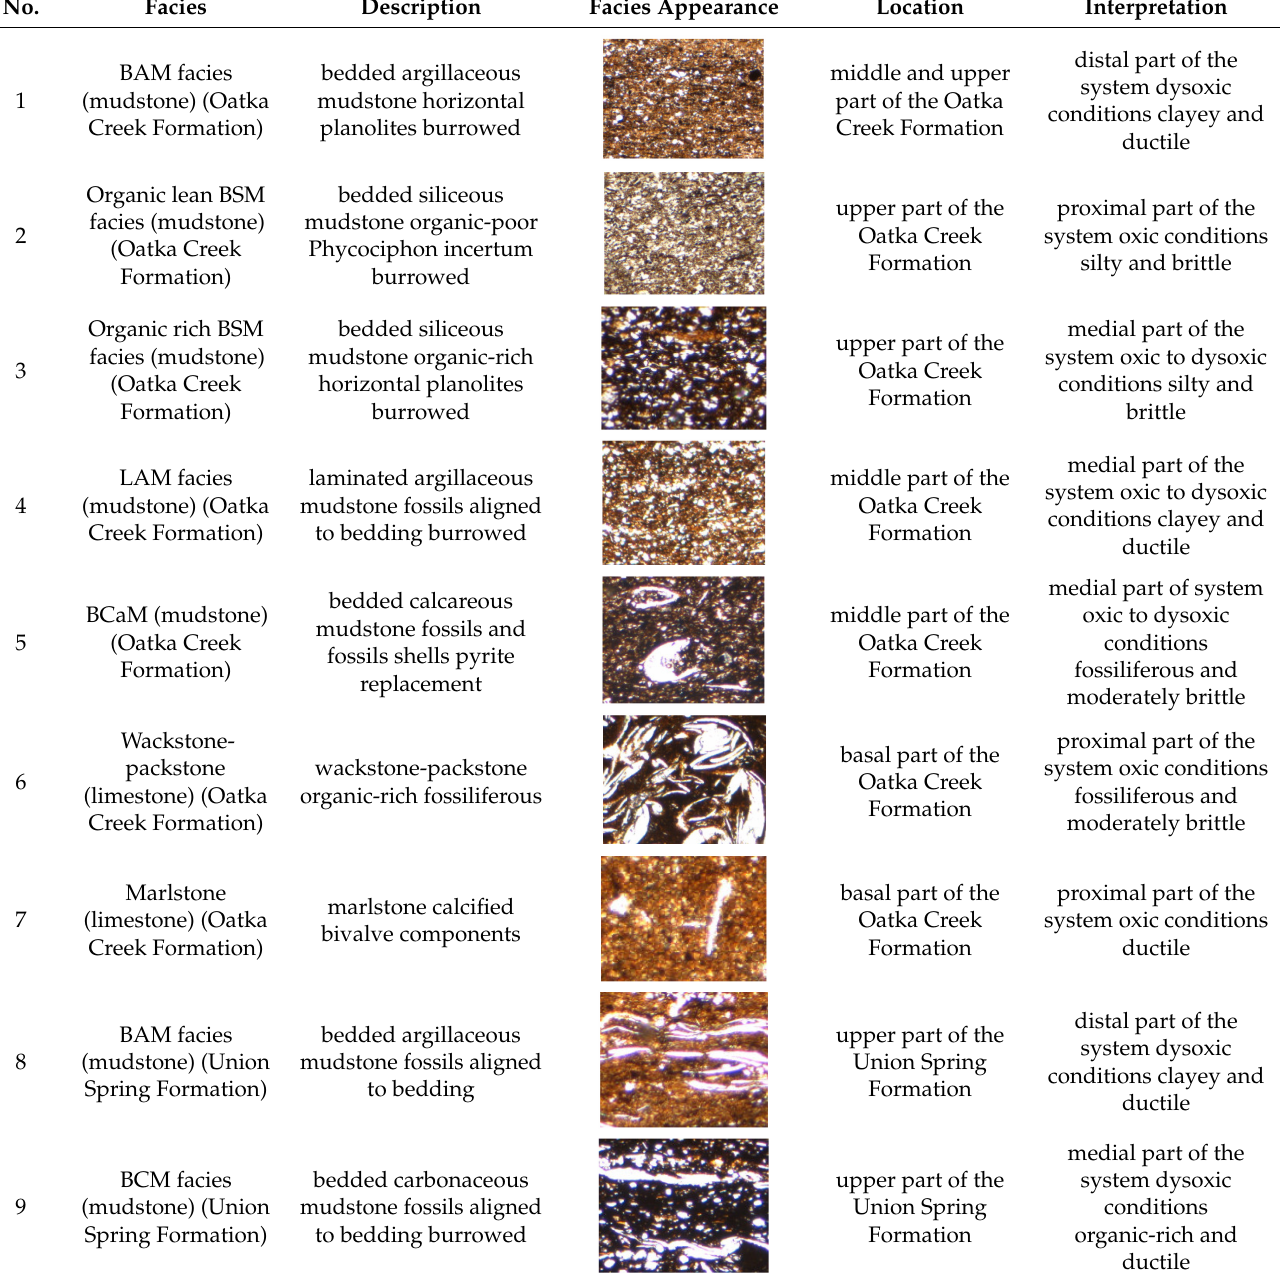
Table 2. Facies in the Oatka Creek Formation and Union Spring